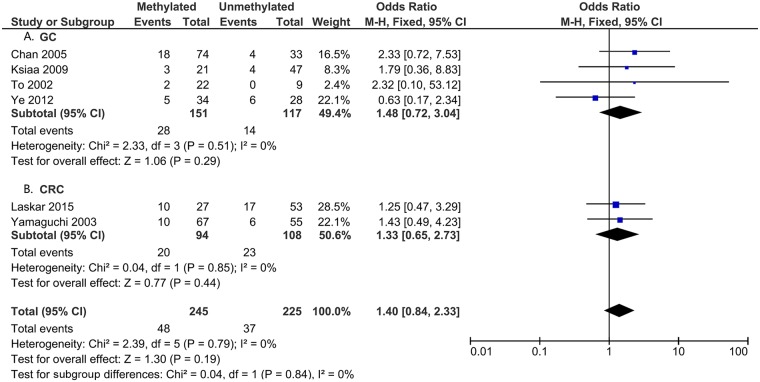
DAPK1 methylation and M stage (M1 vs. M0): A. GC; and B. CRC.